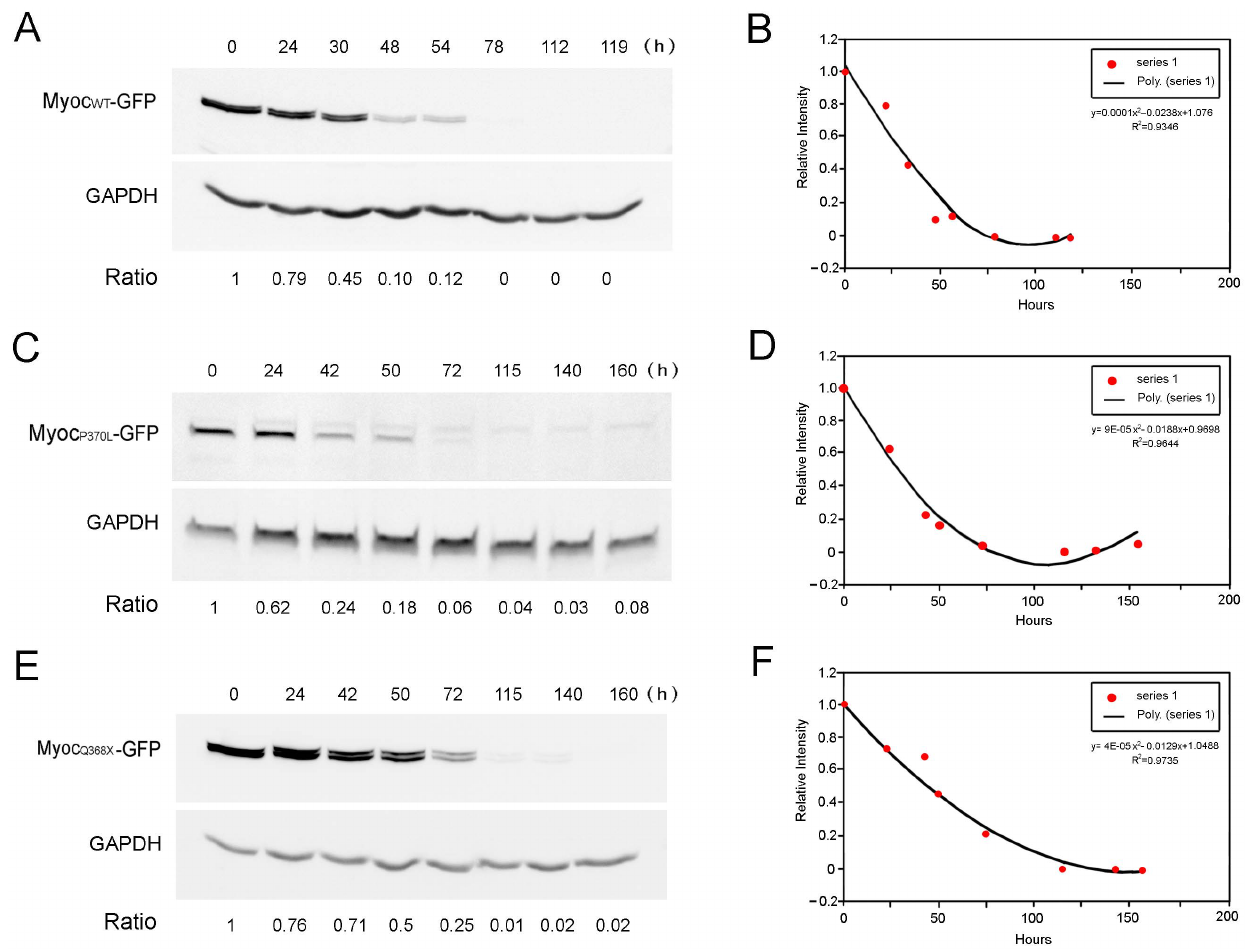
Figure 5. Turnover of overexpressed myocilin (wild-type or mutant)-GFP fusion proteins. Tet-on inducible RGC5 cells were treated with Dox (1 m g/ml) for 24 h to express a moderate level of wild-type (Myoc WT , A ), mutant P370L (Myoc P370L , C ) or Q368X (Myoc Q368X , E ) myocilin-GFP fusion protein. After washing, cells were incubated in growth medium containing 1% fetal bovine serum (without Dox) and were harvested at various time points. Monesin (2 m M) was added to the wild-type myocilin-expressing cells to block the myocilin secretion. The levels of fusion proteins were measured by Western blotting. The relative intensity of the induced wild-type ( B ), P370L ( D ), and Q368X ( F ) myocilin-GFP to that of GAPDH was plotted against time to estimate the half-life. The half-life of wild-type-, P370L-, and Q368X-myocilin-GFP was approximately 24, 42, and 50 h, respectively. The turnover rate of overexpressed wild-type myocilin and mutants was much slower than that of the endogenous myocilin, suggesting that the protein processing was altered upon myocilin overexpression or mutation. All experiments were repeated at least 3 times, yielding similar results.